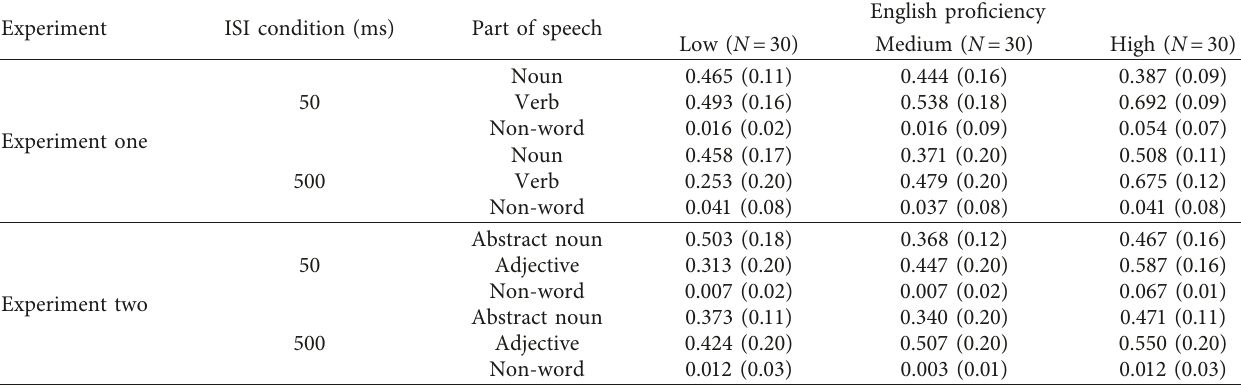
Table 2: Three English proficiency groups’ percentage of part of speech prime judgement